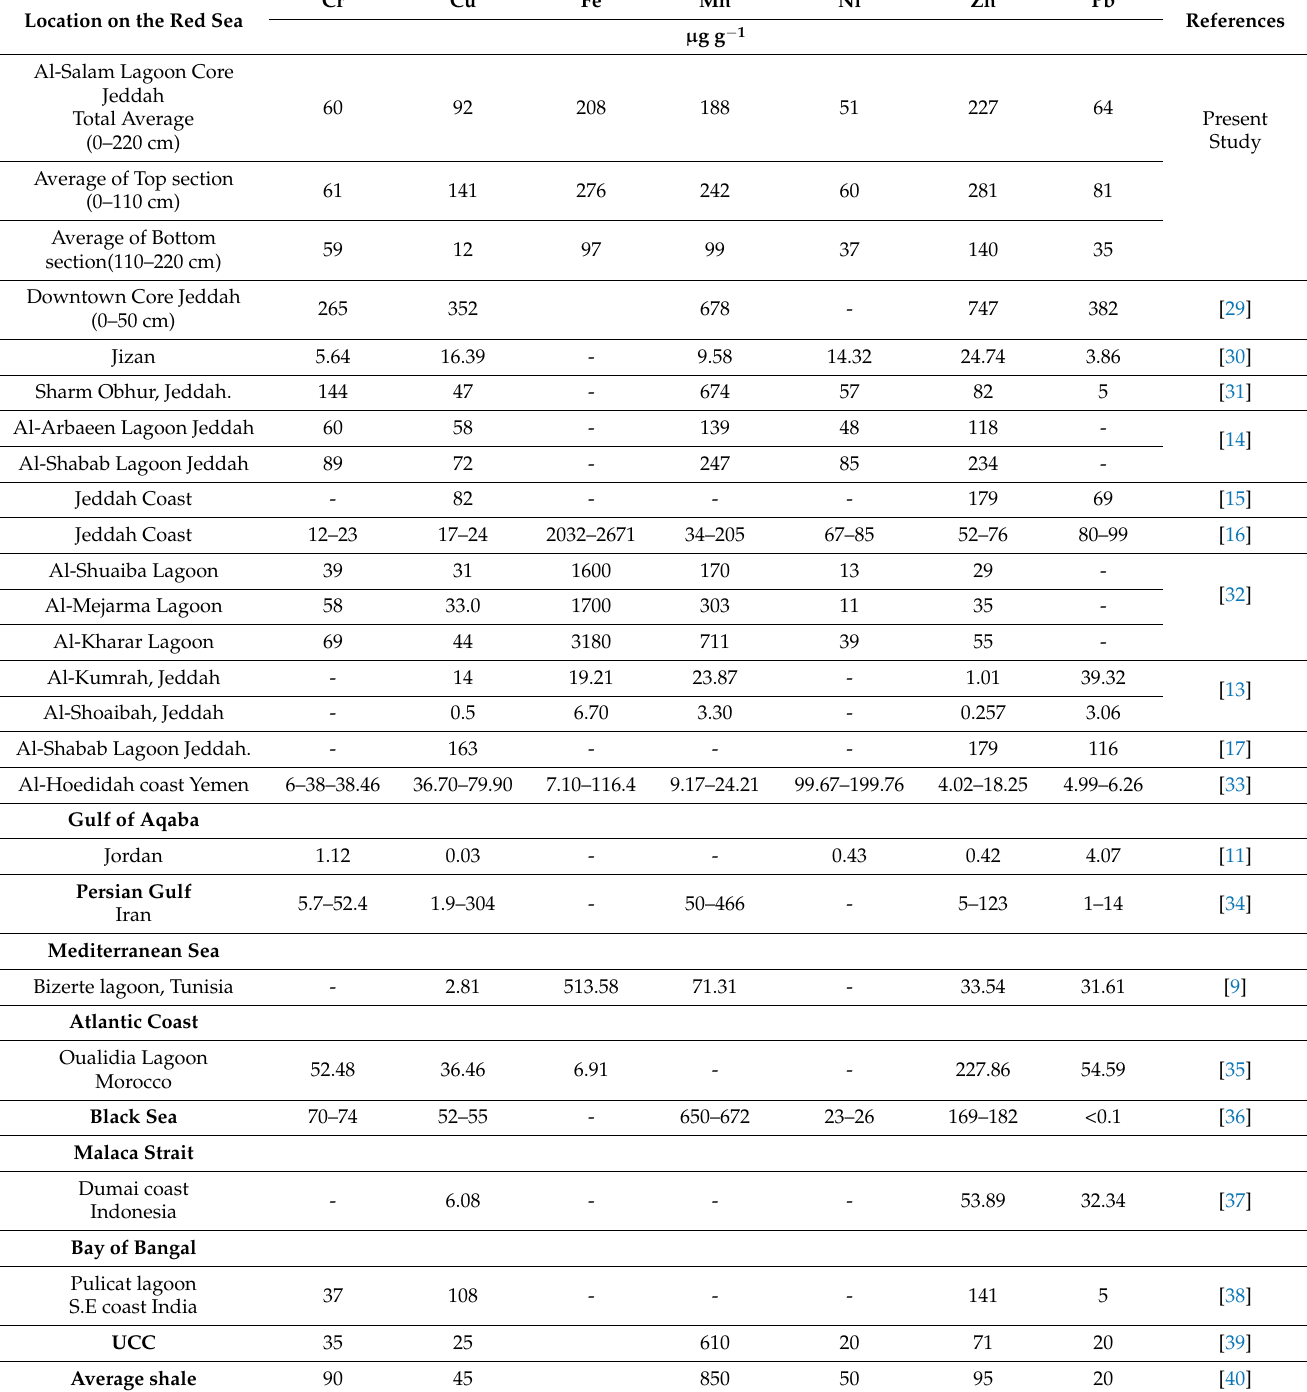
Table 1. Comparison of average concentrations ( µ g g − 1 ) of heavy metals in the core Salam1 sediments from Al-Salam Lagoon, Jeddah coast, and similar published studies from the Red Sea and other world regions. Location on the Red